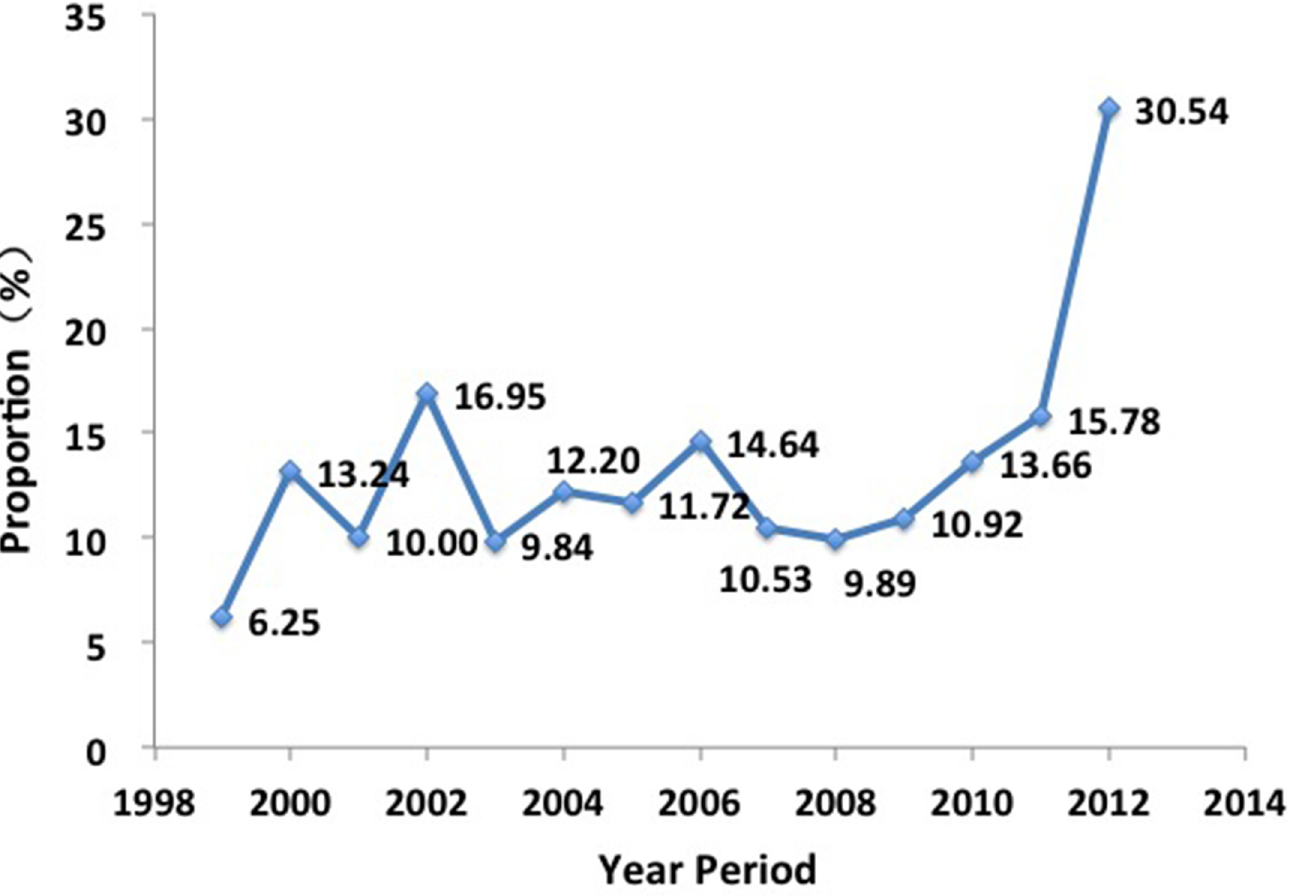
Fig 3. Distribution of early-stage ADC in CHCAMS from 1999 to